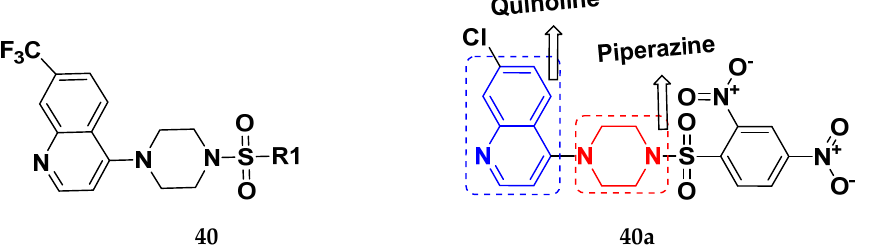
Figure 44. Structure of quinolone-based piperazine hybrids and the most promising compound 40a . Table 33. In vitro cytotoxic activities of quinoline based piperazine hybrids compounds 40 ( b – e ).